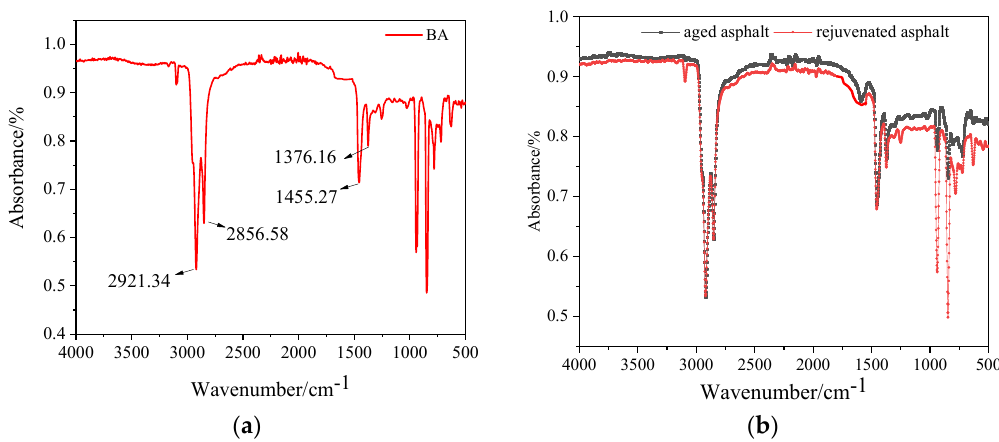
Figure 14. Infrared spectrum test results. ( a ) Base asphalt. ( b ) Aged asphalt and rejuvenated asphalt. It can be seen from Figure 14a that there are six strong absorption peaks in the func- tional group region of FTIR of 70# base asphalt. Through the comparison of characteristic absorption peaks, the absorption peak of BA at wave number 3100–3300 cm −1 is caused by CH stretching vibration. The strong absorption peaks at 2921.34 cm −1 and 2856.58 cm −1 are caused by the stretching vibration of the C-H bond in the methylene group. The absorption peak at 1455.27 cm −1 and 1376.16 cm −1 is the result of bending vibration in C-H plane. The absorption peak at 1630.89 cm −1 is the result of the stretching vibration of the C=C double bond. The range 400–1300 cm −1 is the infrared fingerprint frequency region, in which small changes in the molecular structure will cause changes in its peaks. It was found that 70# BA has more miscellaneous peak changes in the fingerprint area, indicating that it has more internal components. However, it can be preliminarily judged from the functional group region that the mechanism asphalt is composed of saturated and unsaturated carbon chains [31].